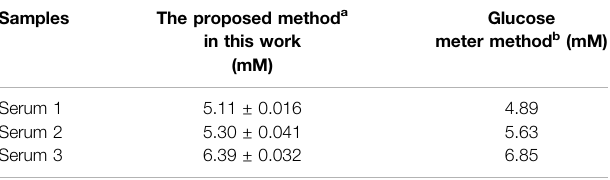
TABLE 5 | Determination of the glucose concentrations in serum samples.